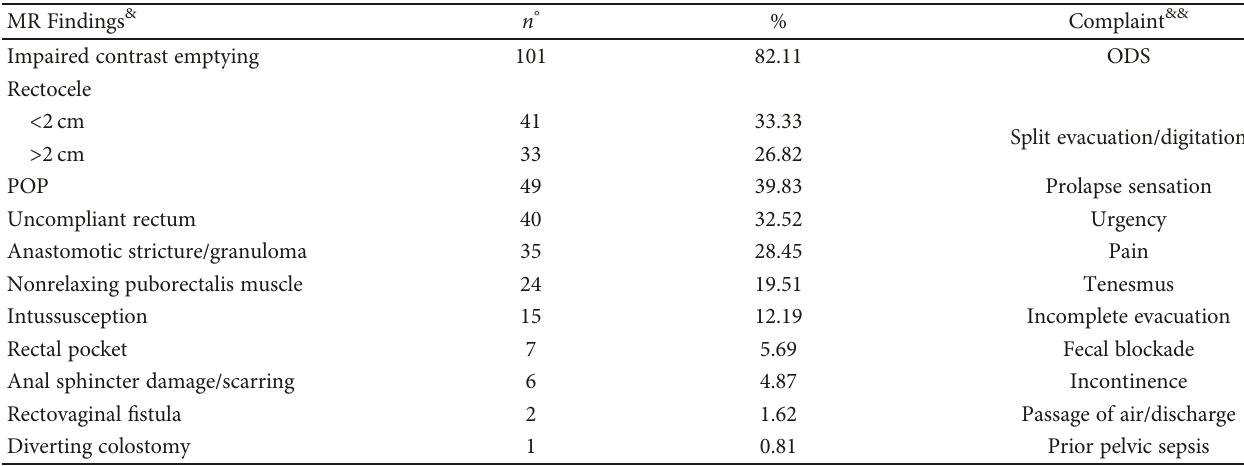
Table 3: Diagnostic yield at MR defecography and related complaints in 123 consecutive patients with STARR